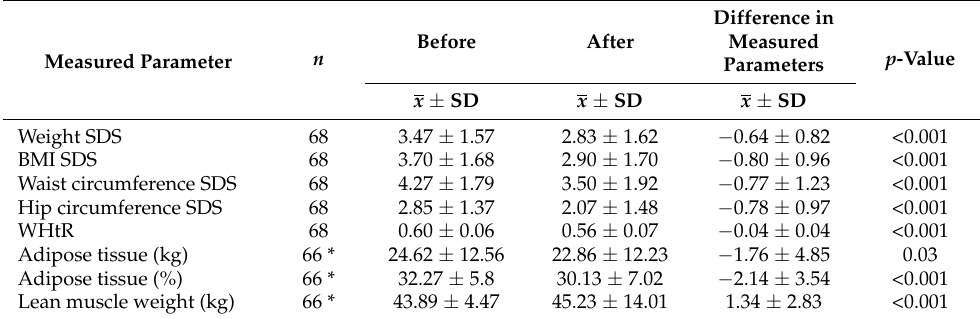
Table 2. Changes in measured anthropometric parameters before and after the dietary intervention.